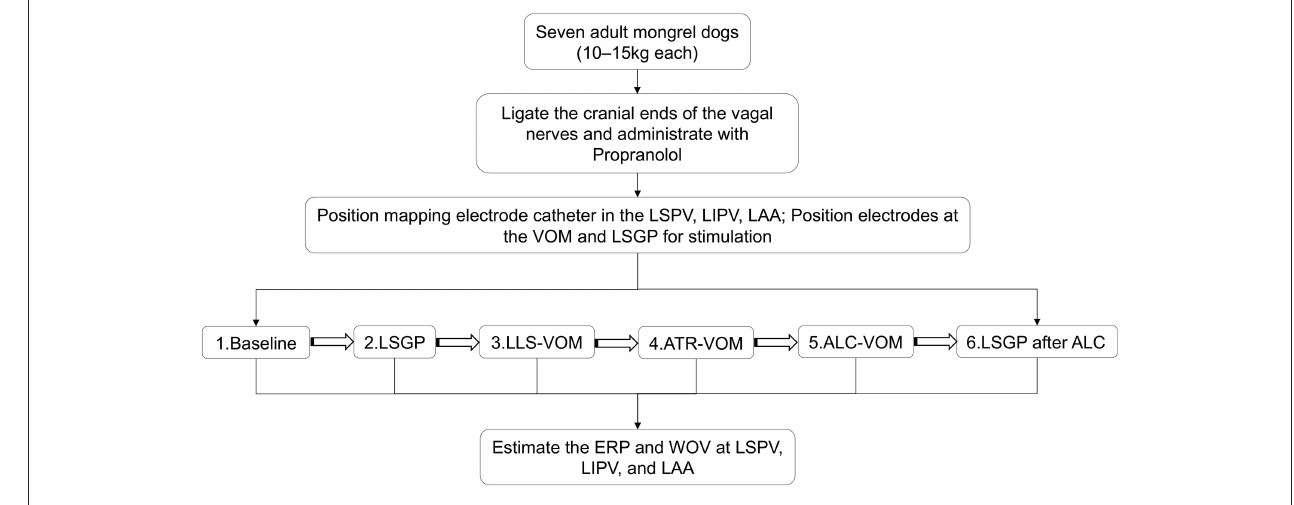
FIGURE 1 | Schematic of the study design.